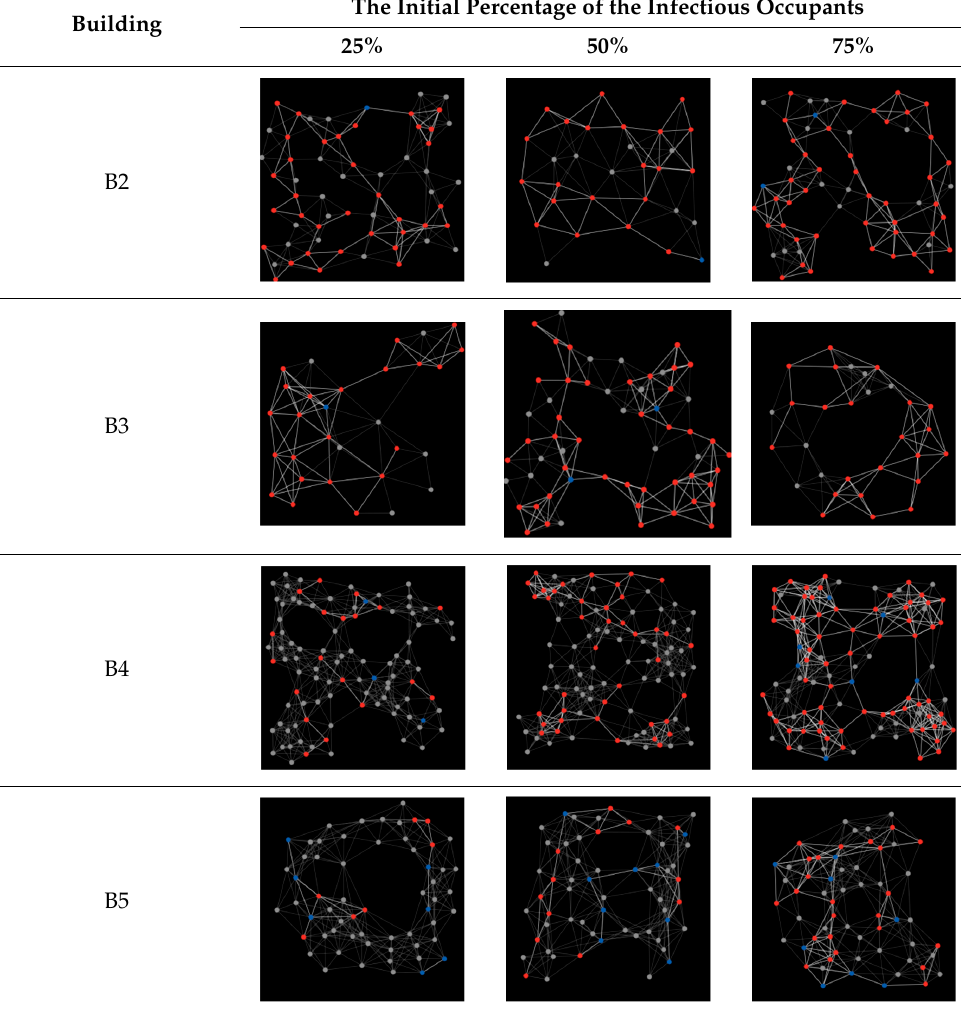
Table 4. The distribution of occupants under different initial percentage of infectious occupants.